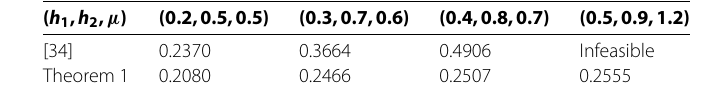
Table 1 The H ∞ performance index γ with different ( h 1 , h 2 , μ